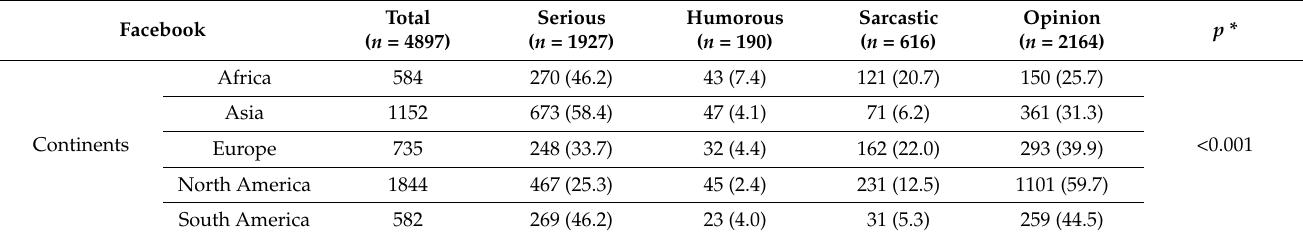
Table 4. Continents tone to COVID-19 vaccination in Facebook and